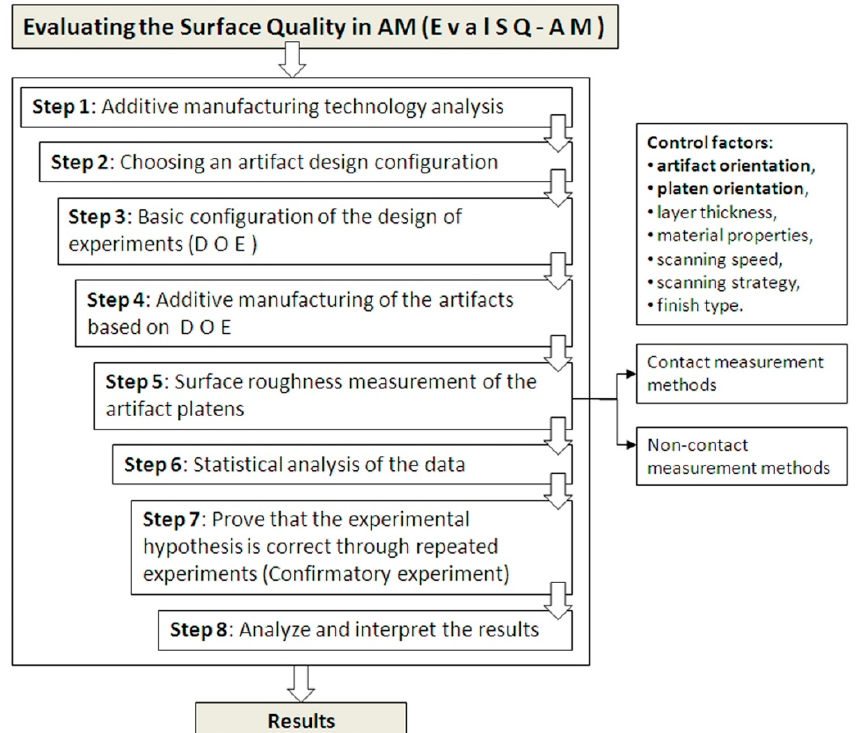
Figure 3. Flowchart of the proposed methodology named EvalSQ-AM.